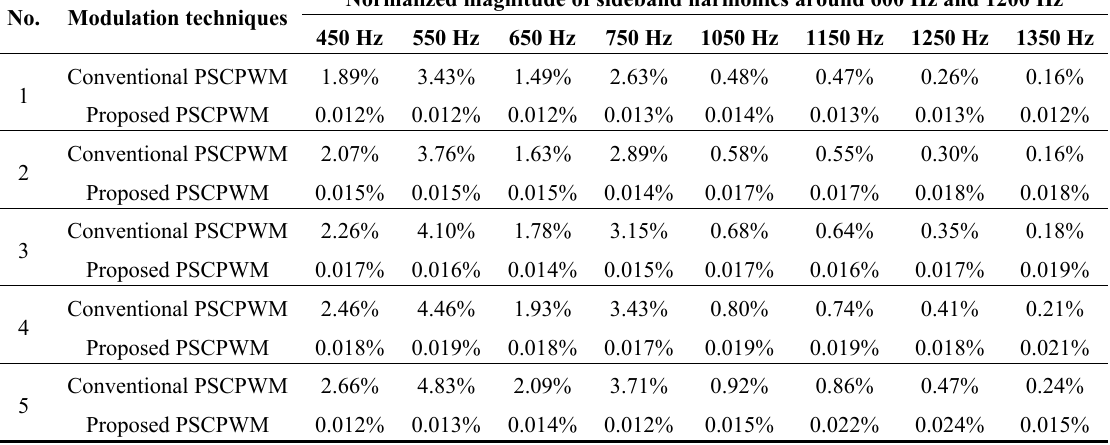
Table 3. Sideband harmonics around 600 Hz and 1200 Hz obtained from the simulations when the conventional PSCPWM and the proposed PSCPWM are used respectively under different combinations of unequal dc